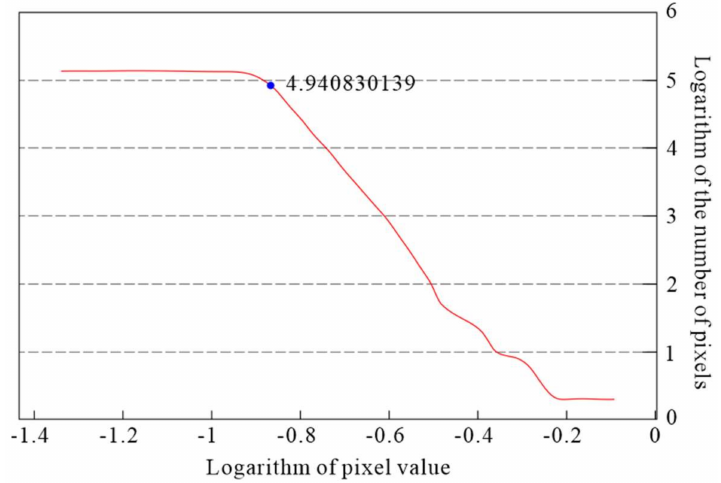
Figure 13. Log–log plot of spectrum-area value for MF